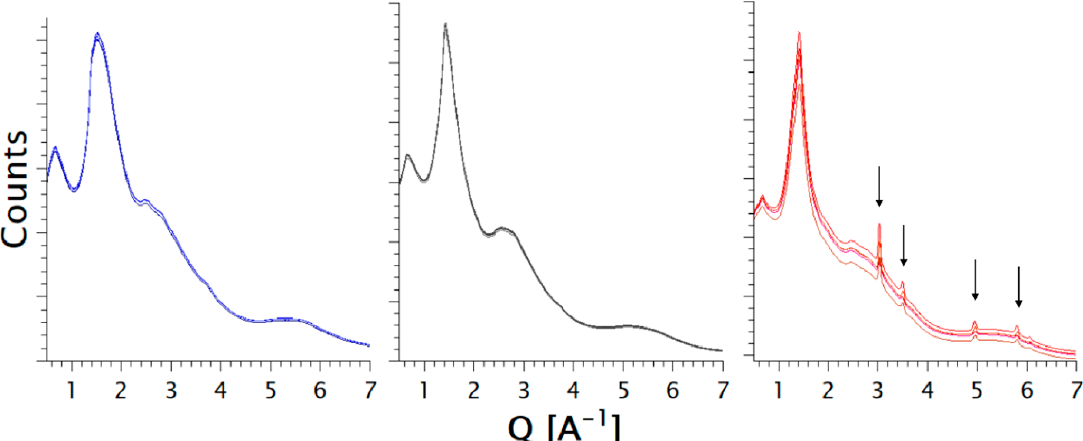
Figure 7. X-ray synchrotron results (i.e., arbitrary counts versus Q vector) of coformers other than amino acids. The additives in addition to NaCMC are: urea (blue), meglumine (black), and TRIS (red). Each diffraction pattern corresponds to a measured area in the extrudate.